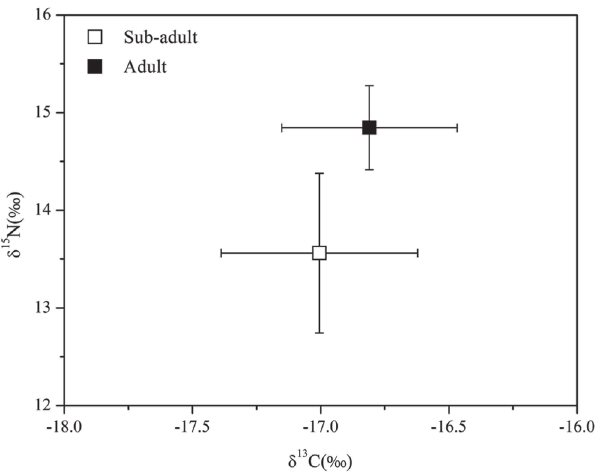
Fig. 4. Correlation between THg (log-transformed) and δ 15 N in the muscle of sub-adult and adult specimens of Trichiurus lepturus